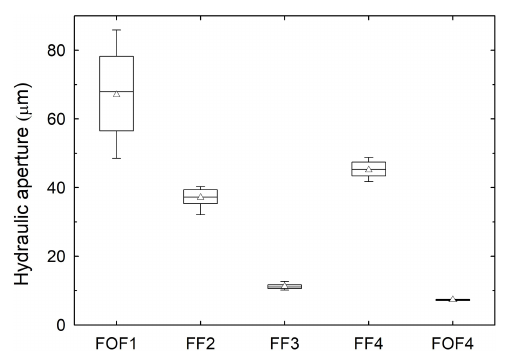
Figure 5. Hydraulic fracture aperture of each sample measured with the transient-airflow permeameter (TP), including a total of 20 val- ues for each sample taken at the top and bottom end faces (see Fig. 1). The solid line and the open triangle in the box indicate the median and mean of each dataset,